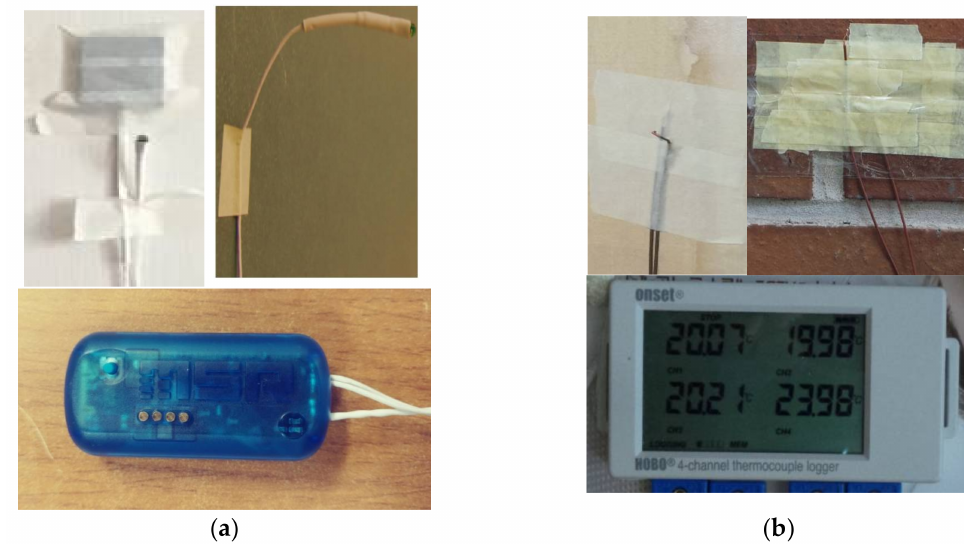
Figure 6. Installation image of the in situ measurement equipment for the HFM method and ASTR method: ( a ) HFM method; ( b ) ASTR